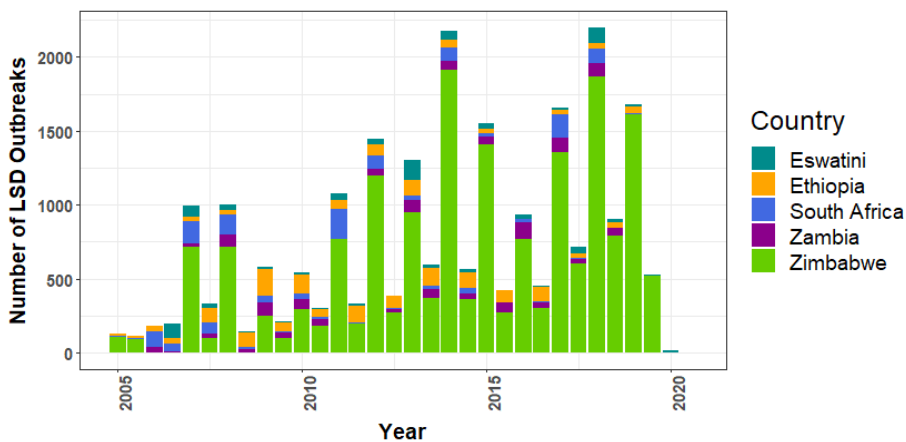
Figure 2. Top five African nations with the most reports of lumpy skin disease outbreaks. In Europe, Russia had the highest number of LSD outbreaks ( n = 524), observed in 2016. North Macedonia, Albania, Montenegro, Russia, and Greece were the top five Eu- ropean nations to report LSD outbreaks that year (Figure 3). After the peak in 2016, the number of reports sharply dropped. From 2018 to 2022, Russia reported LSD outbreaks every year.